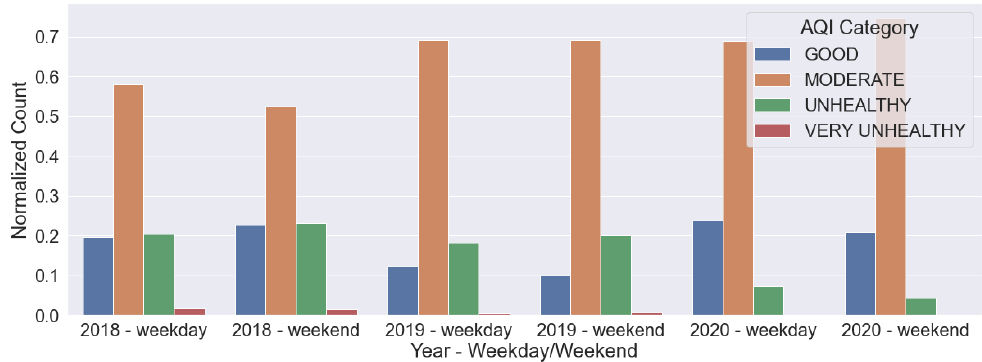
Figure 3. The descriptive statistics of the overall AQI on weekdays versus weekends in 2018, 2019, and 2020. Table 5. The summary of the AQI change within the LSSR phases for all locations. REG1 is the first regular LSSR phase, TR1 is the first transition LSSR phase, REG2 is the second regular LSSR phase, and TR2 is the second transition LSSR phase. Pre-LSSR is the period between 1 January to 28 February, which is before the LSSR phases in 2020. Notice that we did not include March in the pre-LSSR period because the data were missing for the year 2020.